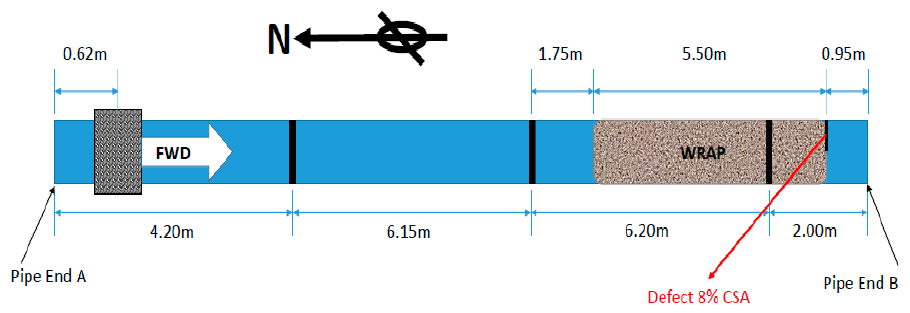
Figure 8. Creating an 8% cross-sectional area (CSA) saw cut defect on Pipe A.